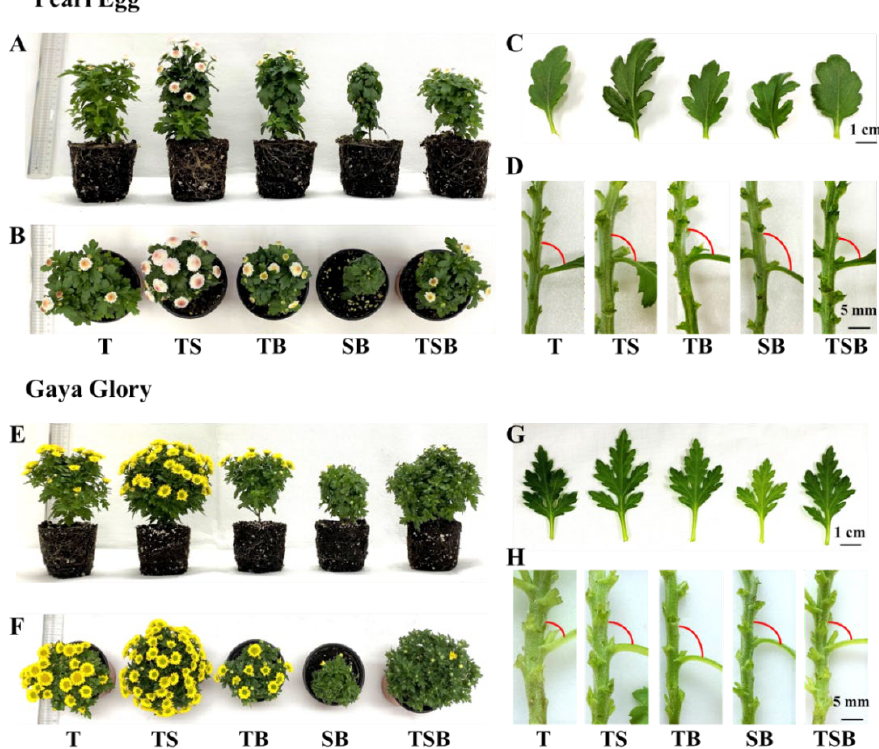
Figure 2. Changes in the phenotype and plant traits of chrysanthemum “Pearl Egg” and “Gaya Glory” plants as affected by the different lighting direction combinations. The plant morphology ( A , B , E , F ), leaf phenotype ( C , G ), and adaxial leaf petiole angle ( D , H ) of “Pearl Egg” and “Gaya Glory” as affected by the different lighting direction combinations after 45 days of cultivation. T, TS, TB, SB, and TSB, refer to the top (1/1), top (1/2) + side (1/2), top (1/2) + bottom (1/2), side (1/2) + bottom (1/2), and top (1/3) + side (1/3) + bottom (1/3) lighting, respectively. Bars indicate 1 cm or 5 mm.